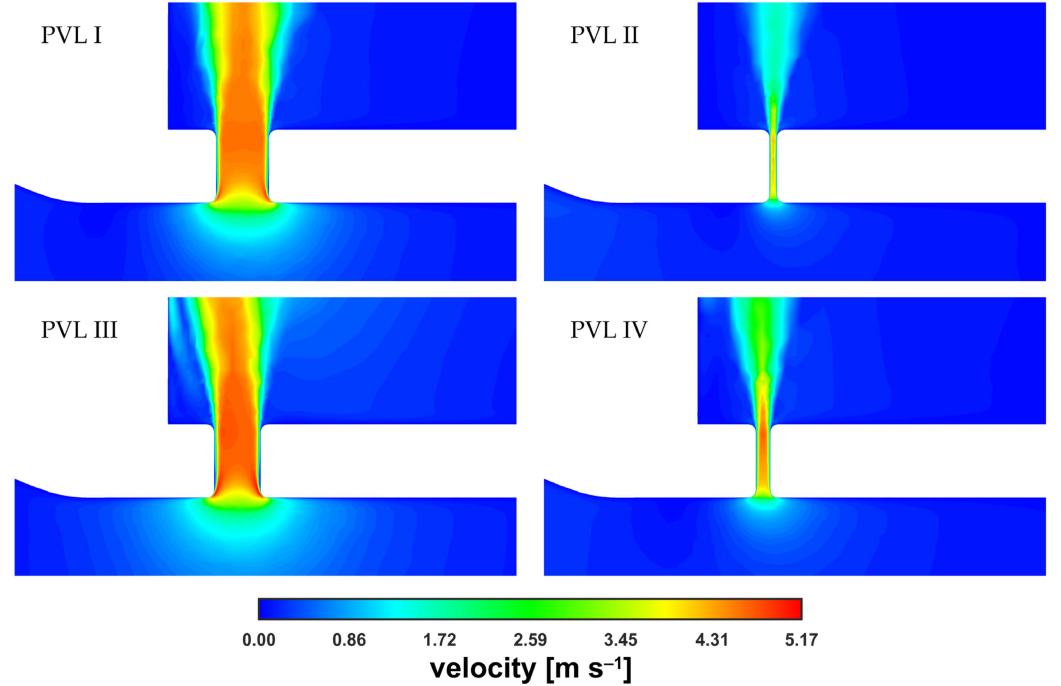
. m = 0.090 kg s − 1 . Figure 7. Contours of velocity magnitude inside PVLs at The velocity magnitude distribution along the PVL axis showed a rapid increase just past the channel entrance. The evolution of the velocity profile was visible (with the transition to a fully developed profile), reaching maximum values of approximately 5 m s − 1 . The profile was rather typical for a duct flow, and observed irregularities in the velocity distribution, i.e., a noticeable asymmetry, could be attributed to the transient nature of the flow. To better show the small differences in maximum velocities, the characteristic values in the channel were listed in Table 2. In the table, u CP was the velocity at the exact